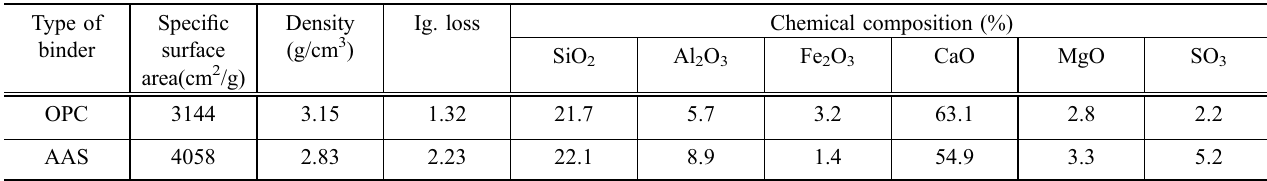
Table 1 Physical properties and chemical composition of binder.